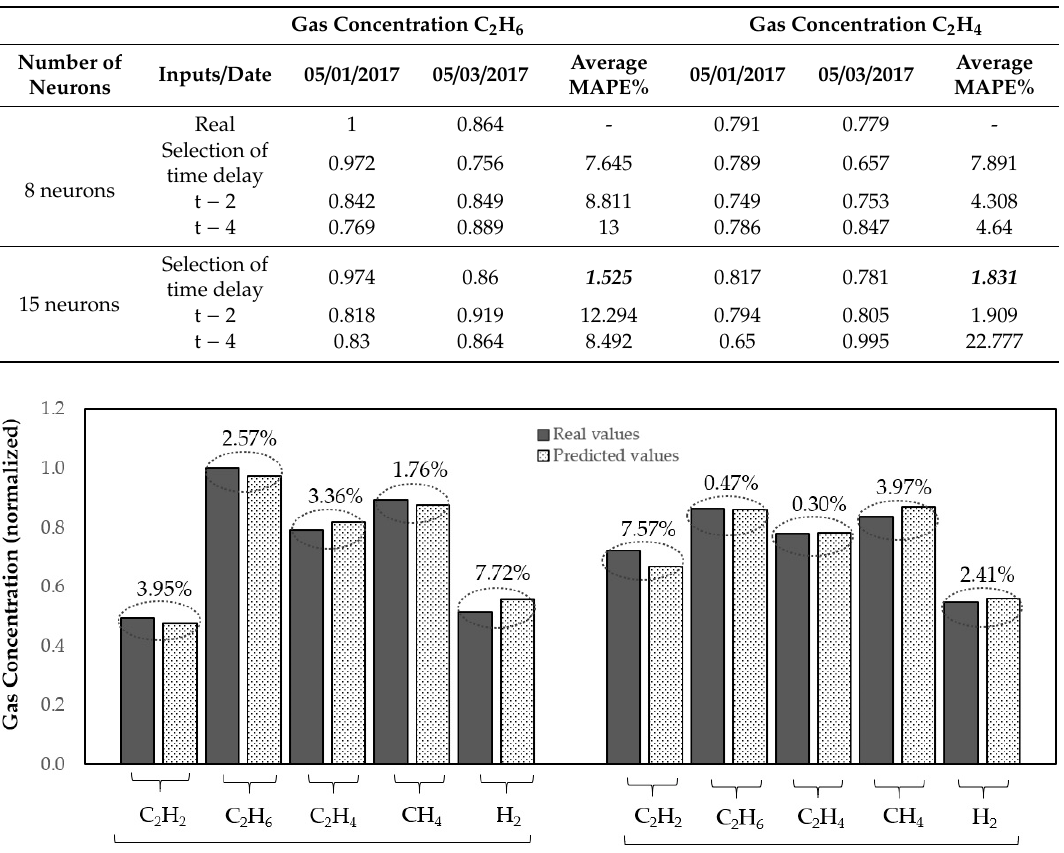
Table 7. Predicted values with and without selection of best delay time. MAPE, mean absolute percentage error.